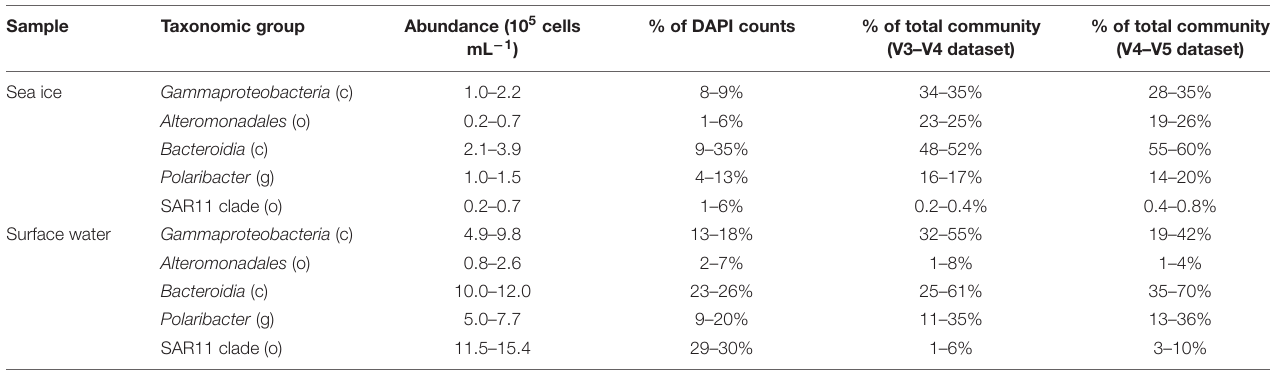
TABLE 1 | Overview of cell abundances and sequence proportions range in selected taxonomic